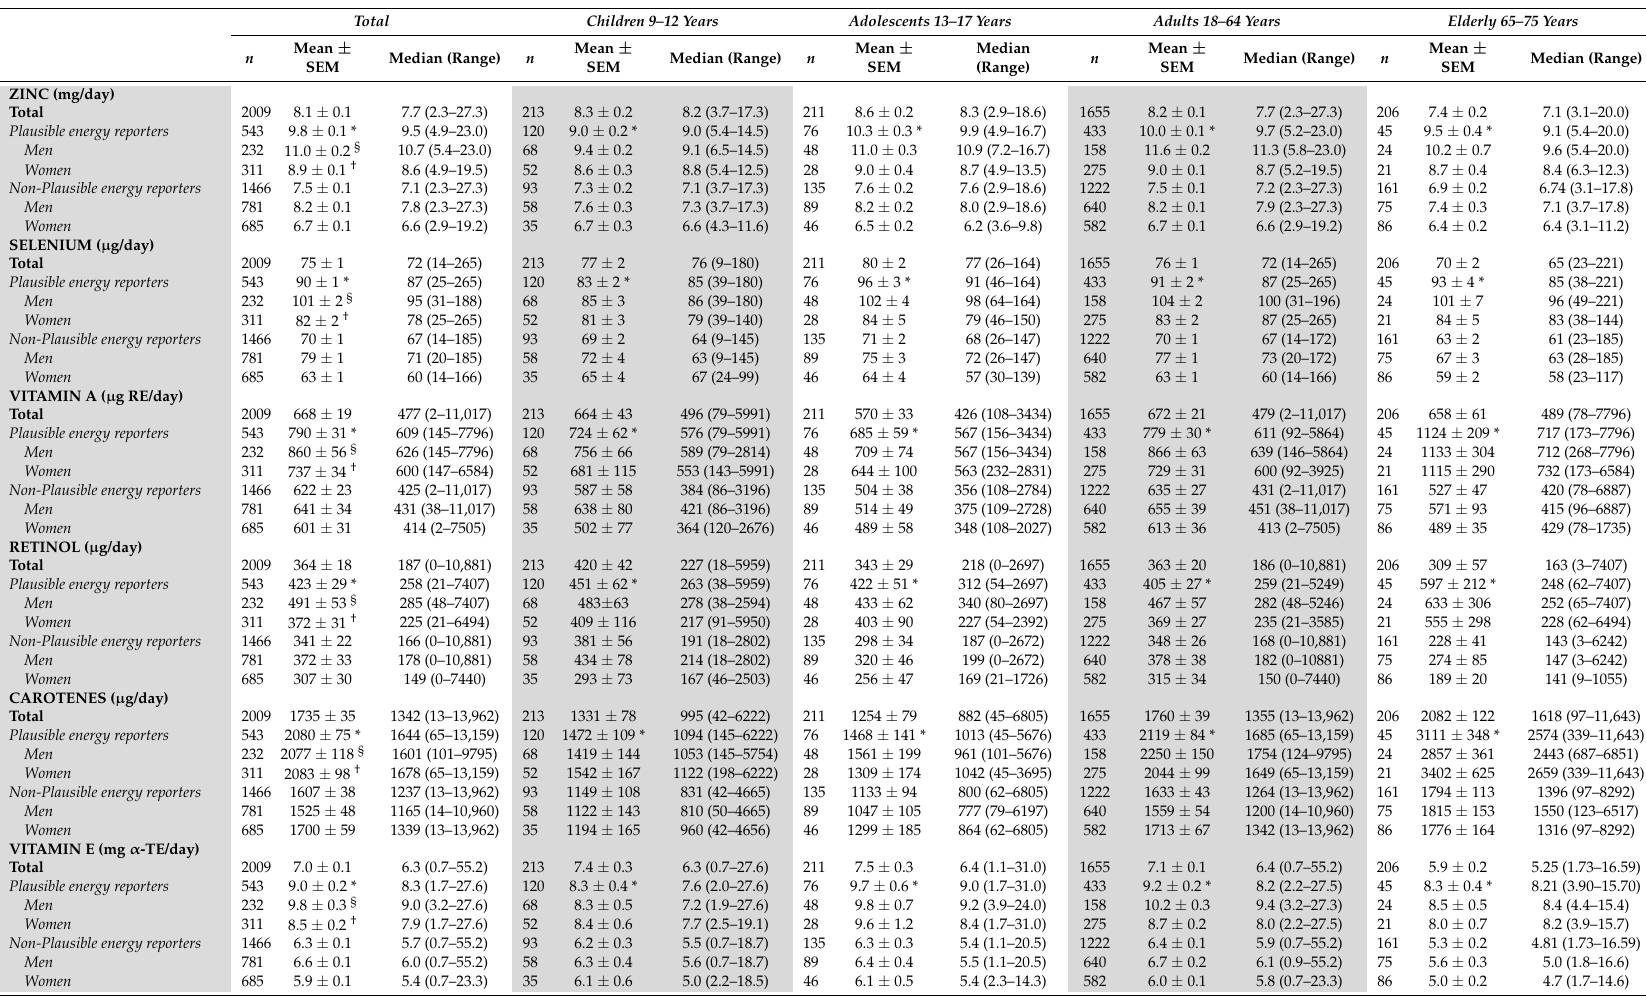
Table 3. Daily zinc, selenium, vitamin A, retinol, carotenes, vitamin E and vitamin C reported intake by plausible energy reporters, non-plausible energy reporters and age group in the ANIBES Study